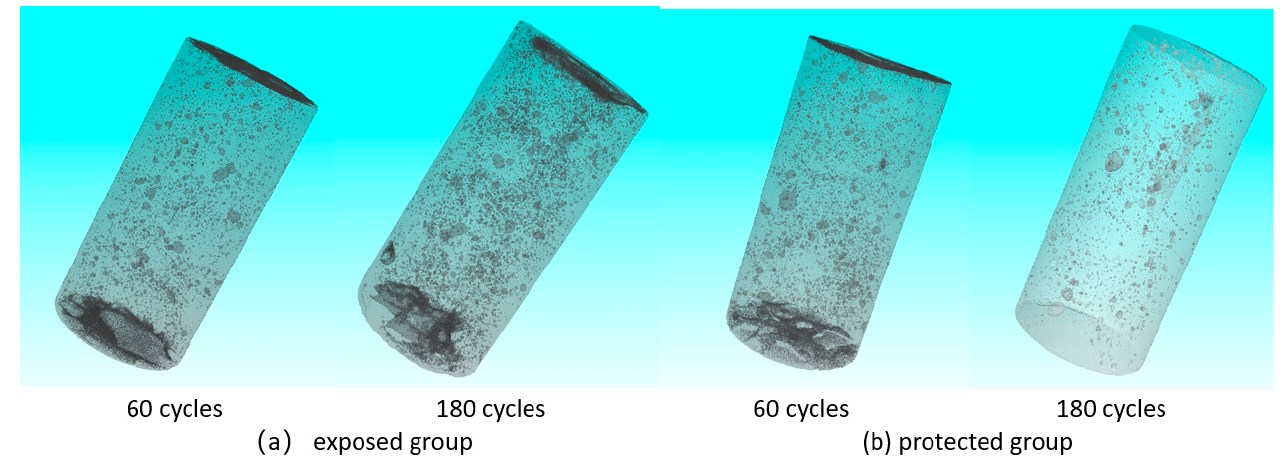
Figure 8. ( a ) Three-dimensional pore-structure reconstruction of specimens in the exposed group; ( b ) Three-dimensional pore-structure reconstruction of specimens in the protected group. Figure 9 reflects the overall pore-structure change and the respective pore size com- position of the two groups of specimens during the erosion process. From the overall